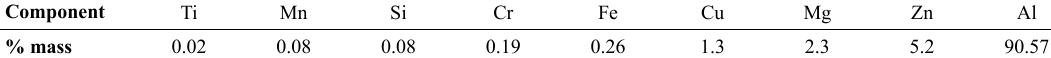
Table 1. Chemical composition (mass %) of AA 7075 used in the present work. Component